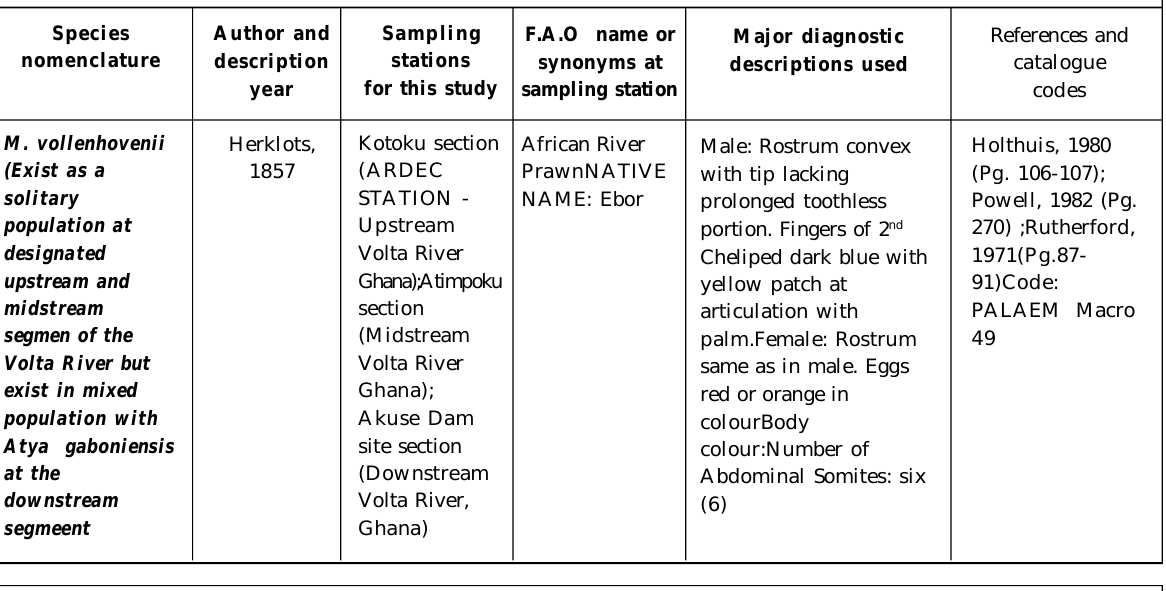
Table 1: Indices for identification of M. vollenhovenii on studied sections of lower volta river Species